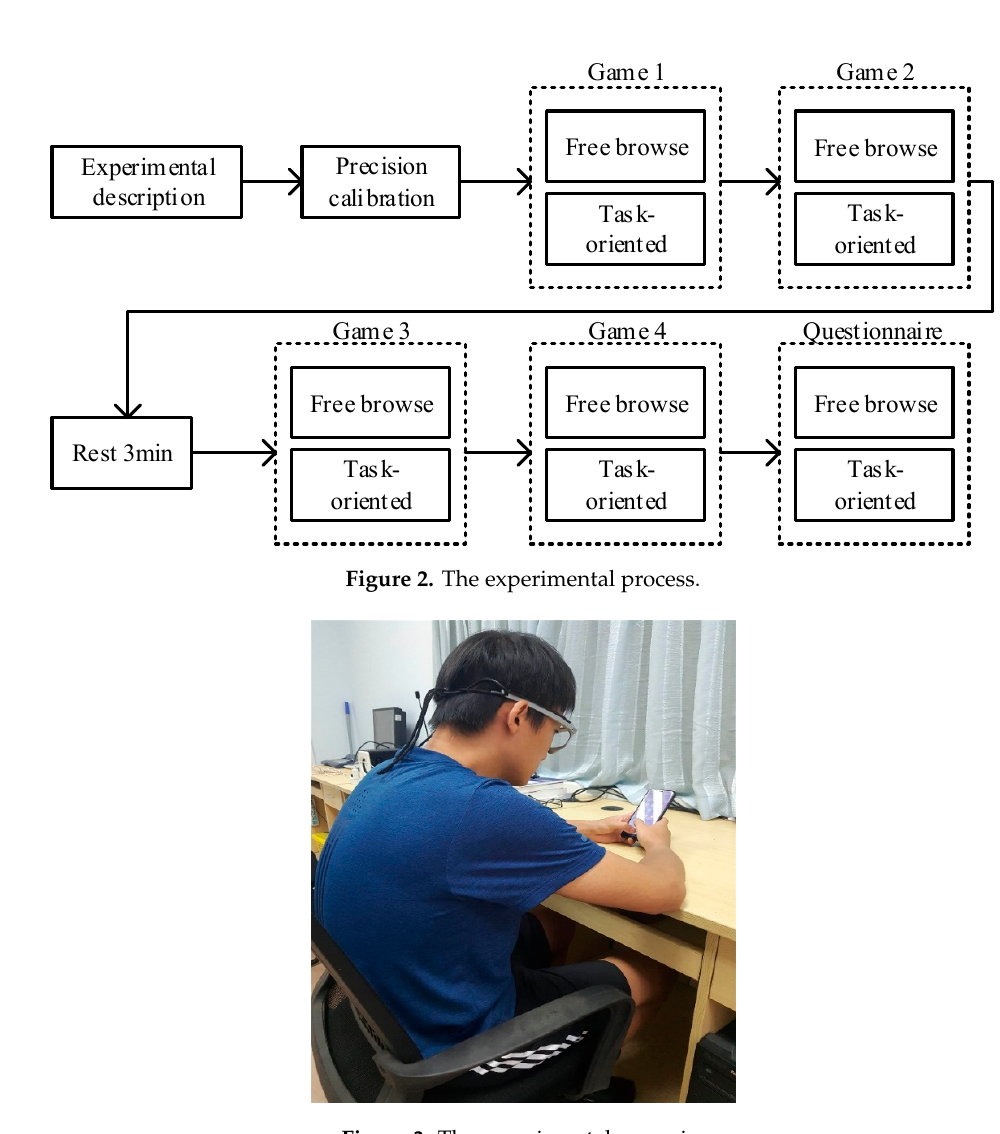
Figure 3. The experimental scenario.